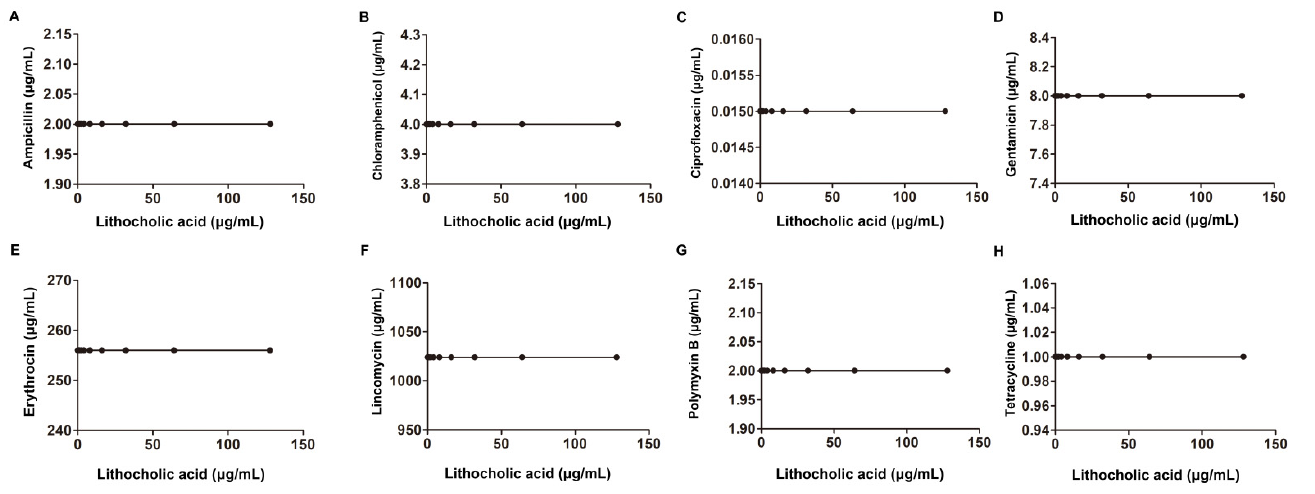
Figure 7. Interaction of LCA with Amp, Ery, Genta, Cip, Lin, Tet, Cpl and Pmb against Salmonella SL1344 ( A – H ).